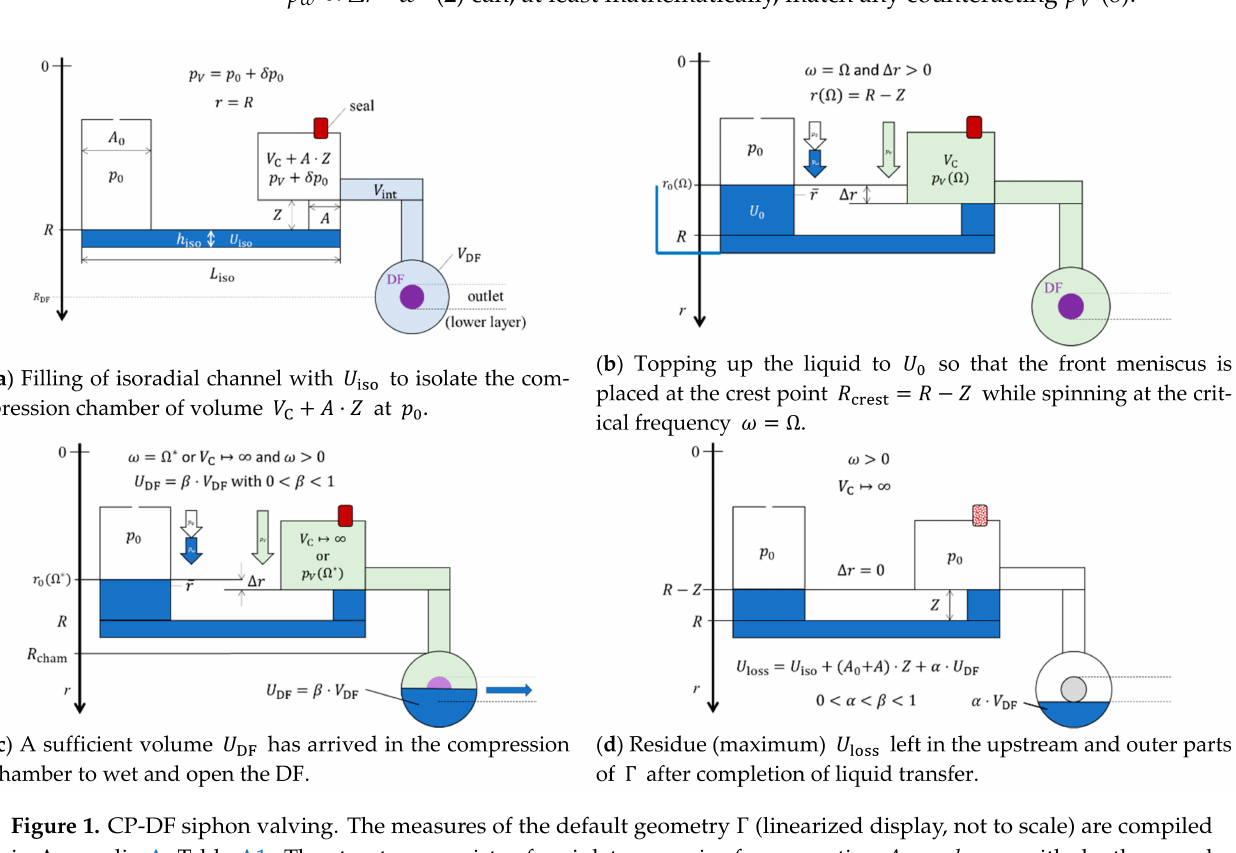
Figure 1. CP-DF siphon valving. The measures of the default geometry Γ (linearized display, not to scale) are compiled in Appendix A, Table A1. The structure consists of an inlet reservoir of cross-section A 0 = d 0 · w 0 with depth w 0 and width w 0 , which is connected through a (narrow) isoradial channel of volume U iso = d iso · L iso · h iso positioned at R to an inbound section of radial extension Z and cross-section A = d · w of depth d and width w . (For the sake of simplicity, d 0 = d iso = d = 1 mm is chosen in this rudimentary layout.) During retention, the outer part represents the gas-filled compression chamber, with a main compartment of volume V C,0 , isoradial and radial sections of aggregate volume V int (with V int (cid:28) V C,0 ) connecting to a shallow round chamber of volume V DF (with V DF (cid:28) V C,0 ) centered at R DF . This outer compartment of volume V DF features a dissolvable-film (DF) membrane. This DF intermittently covers a centrally placed vertical via leading to an outlet in a lower layer until a liquid volume U DF = β · V DF with geometry-dependent coefficient 0 < β < 1 (here: α = 1/2) has arrived. A fraction α · V DF with α < β remains in the receiving chamber after